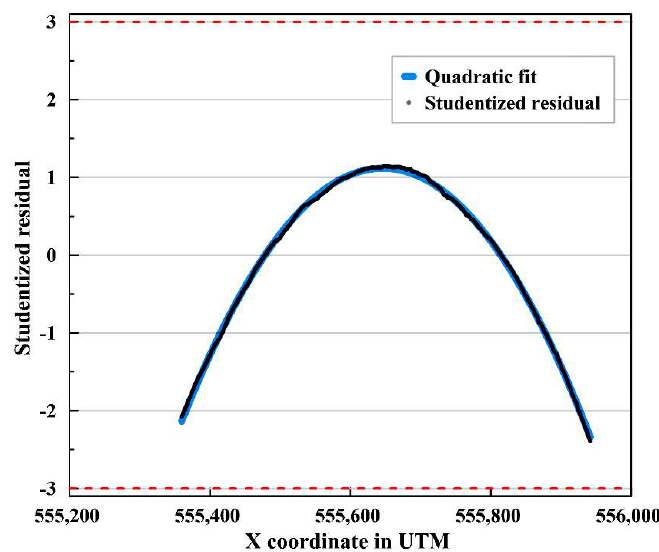
Figure 6. Linearity assessment using studentized residuals of the trajectory of the IBRV Araon during the period of acquisition of the image subsets.